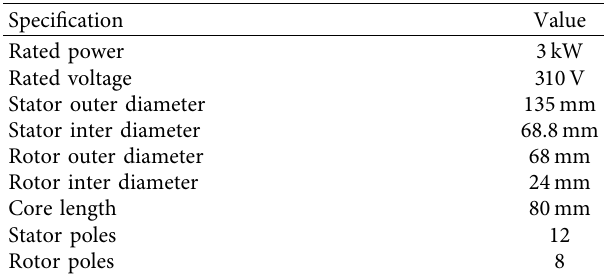
Figure 1: Schematic of the SRM. (a) No auxiliary slot. (b) Stator with auxiliary slot. (c) Rotor with auxiliary slot. (d) Double auxiliary slot. Table 1: Basic parameters of